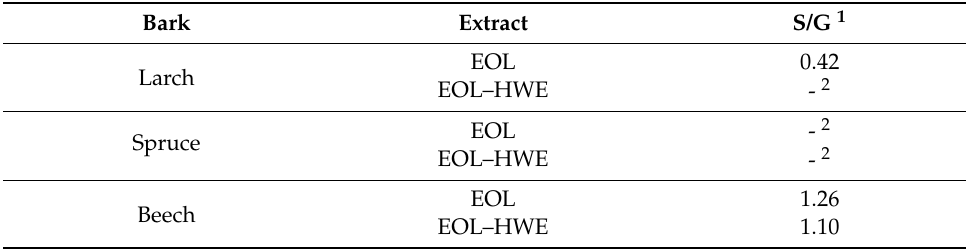
Table 1. S/G ratio of investigated bark lignins.